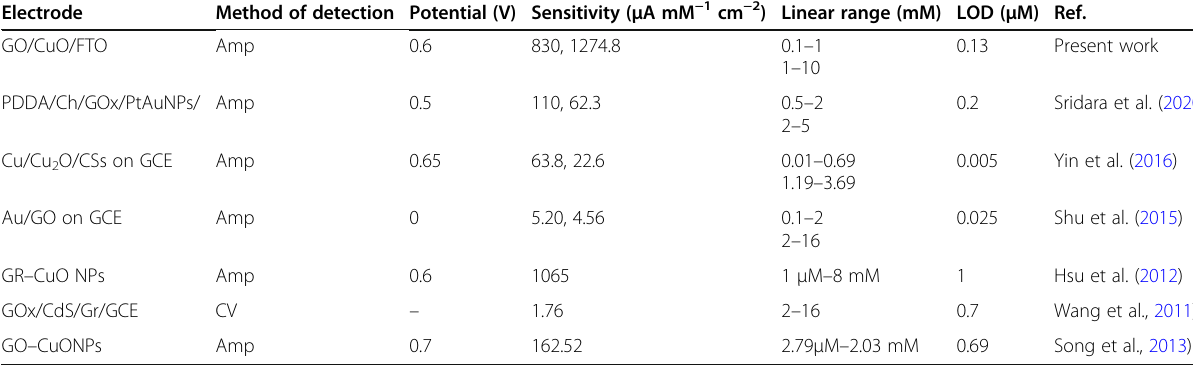
Table 1 Comparison of the enzyme-free GO-based glucose sensor with its composites Electrode